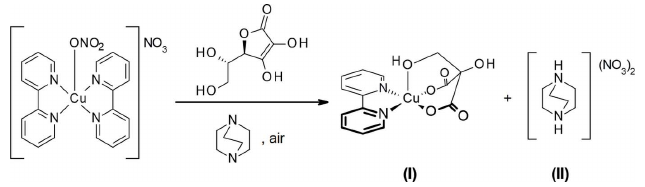
Figure 1 Preparation of the title compound, Cu(bpy)(C 4 H 4 O 6 ) (I), with [DabcoH 2 ](NO 3 ) 2 (II) as byproduct.